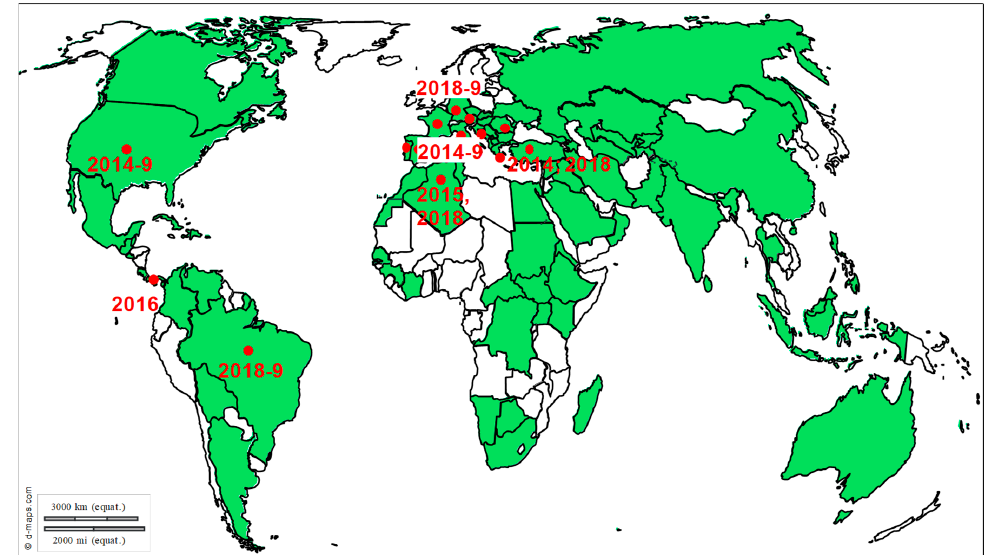
Figure 7. Distribution of WNV outbreaks. Recent outbreaks in horses reported to the OIE WAHIS interface [15], Promed Alerts [16] or in the scientific literature are depicted by dots (2014–2019). TBEV and LIV